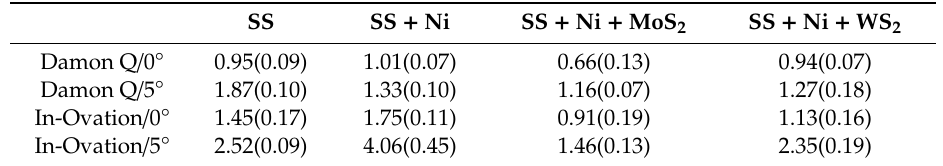
Table 3. Mean and standard deviation of five measurements of the frictional force in wet condition. SS SS + Ni SS + Ni + MoS 2 SS + Ni + WS 2 Damon Q / 0 ◦